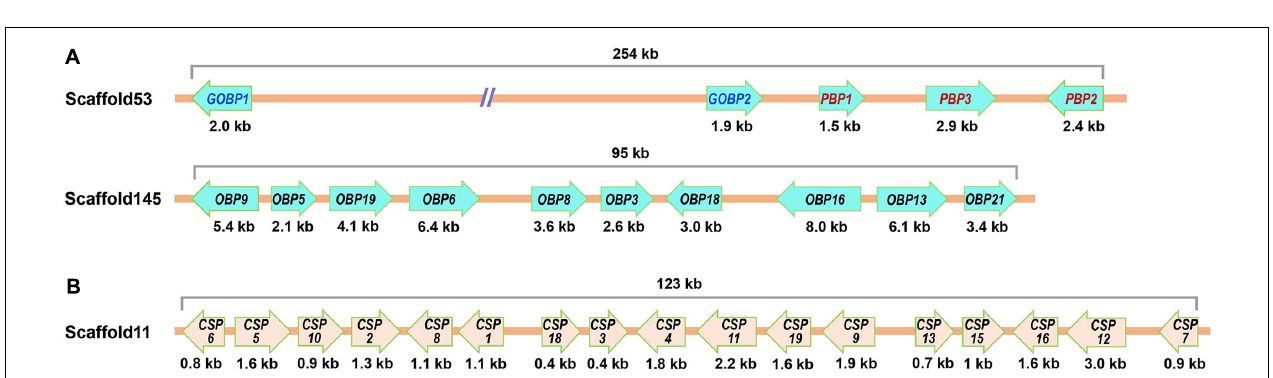
Frontiers in Physiology |